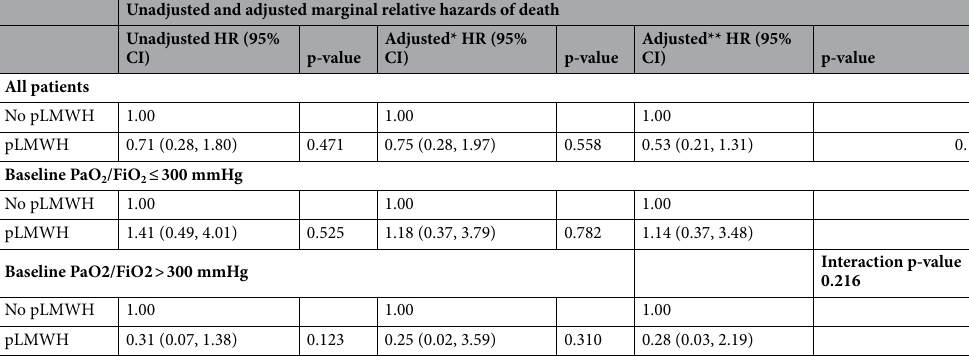
Unadjusted and adjusted marginal relative hazards of death Unadjusted HR (95%